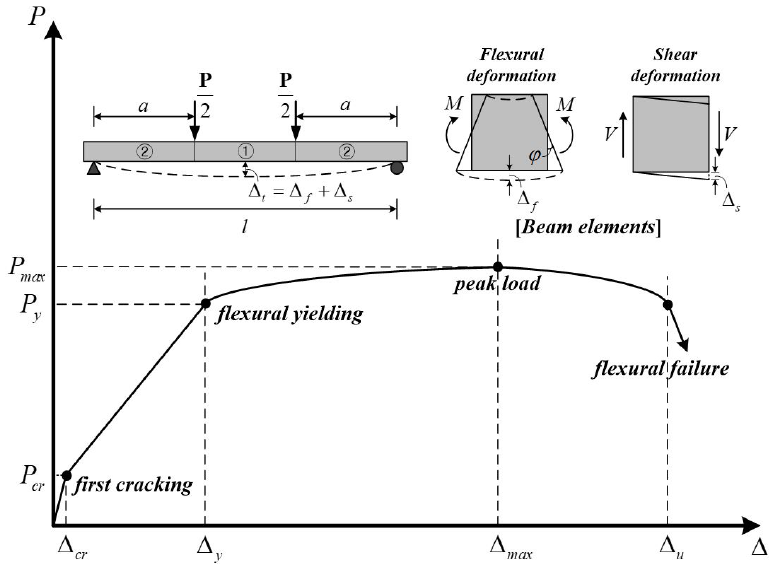
Figure 1. Typical load-deflection behavior of flexure-critical RC